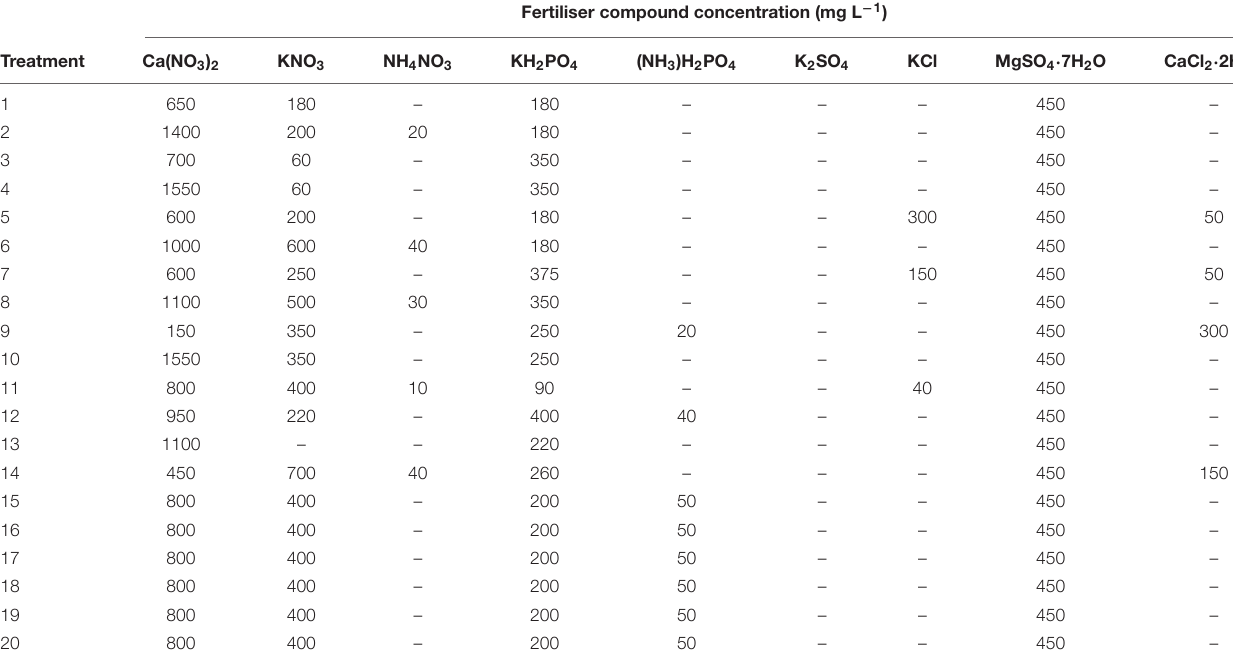
TABLE 3 | Amount of each straight fertiliser compound used to make treatment nutrient